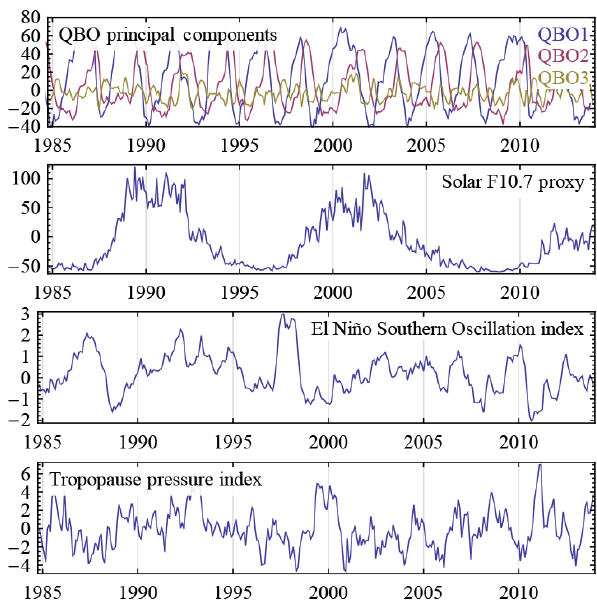
Figure 5. The six non-linear basis functions used to fit the ozone anomaly. From top down: the first three principal components of the multi-level QBO; the F10.7 solar proxy; the El Niño–Southern Oscillation index with a two month lag; deseasonalized tropopause